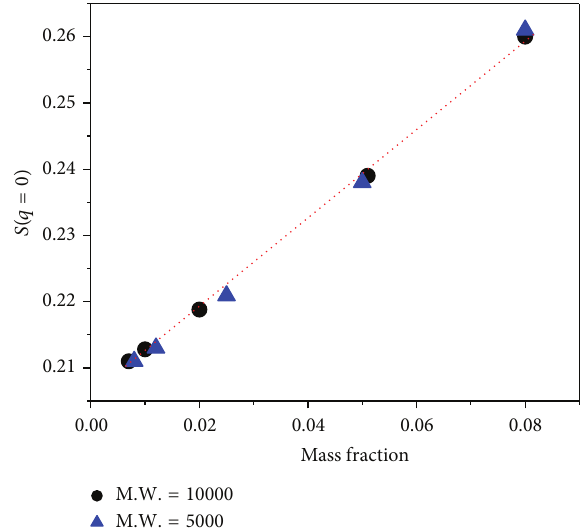
Figure 5: The structure factor of a mixture as a function of polymer mass fraction of C 12 E 5 /water/n-decane at 𝑞 = 0 at a constant droplet /𝑚 = 1.08. The circle points are PCL mass fraction (0.2) and 𝑚 Dec C 12 E 5 with M.W. = 5000 and up-triangle is PCL with M.W. =